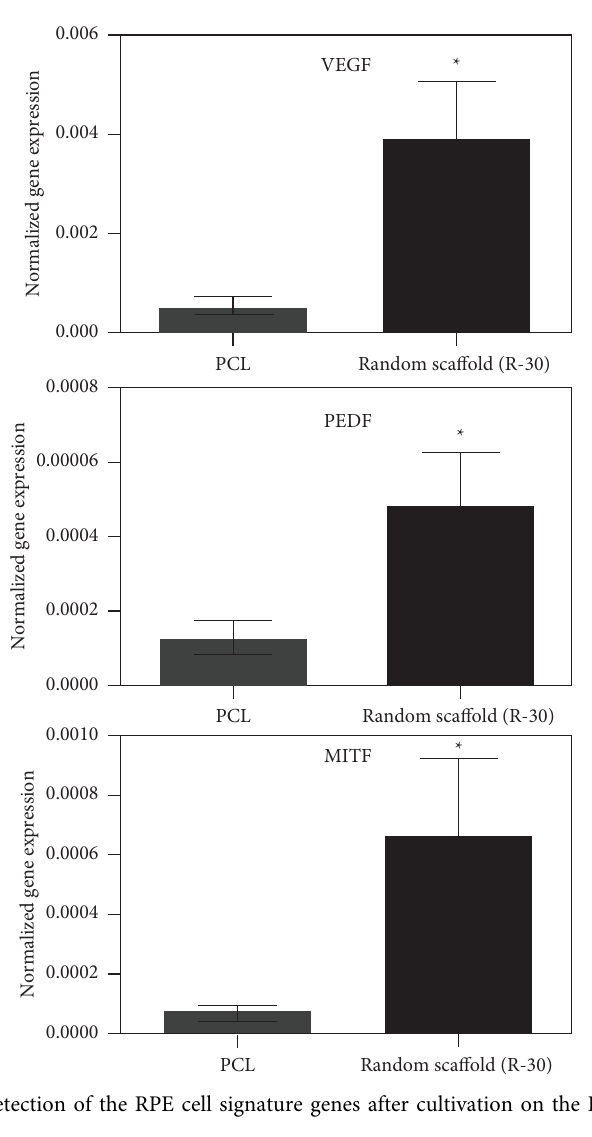
Figure 10: Quantitative RT-PCR detection of the RPE cell signature genes after cultivation on the R-30 and PCL scafolds for 1 week.